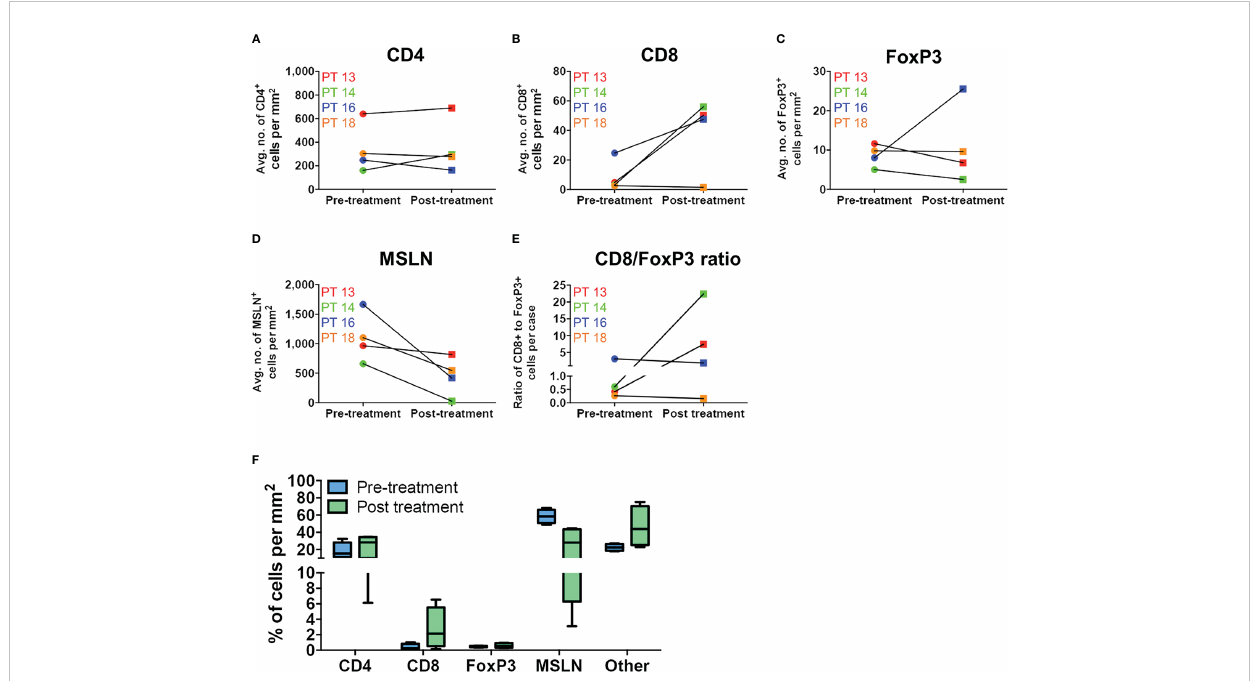
FIGURE 4 Immune cell in fi ltration in matched MPM tumor specimens before and after Olvi-vec therapy. (A – D) Matched MPM tumor sections obtained before and after Olvi-vec therapy underwent mIF staining and quanti fi cation of (A) CD4+ T cells, (B) CD8+ T cells, (C) FoxP3+ T cells, and (D) mesothelin (MSLN)+ tumor cells. (E) The ratio of CD8+ to FoxP3+ T cells in pre- and post-treatment tumor sections was calculated to identify patients with immunogenic (CD8+/FoxP3 + >1) vs. immune suppressive (CD8+/FoxP3+ <1) tumor microenvironments. (F) Immune cell populations present in matched pre- and post-treatment tumor sections were expressed as a percentage of total cells per mm 2 . “ Other ” cells are DAPI+ but negative for CD4, CD8, FoxP3, and MSLN — they may be fi broblasts, mesothelial cells, or other classes of immune cells. Bars indicate mean, interquartile range, and SEM.